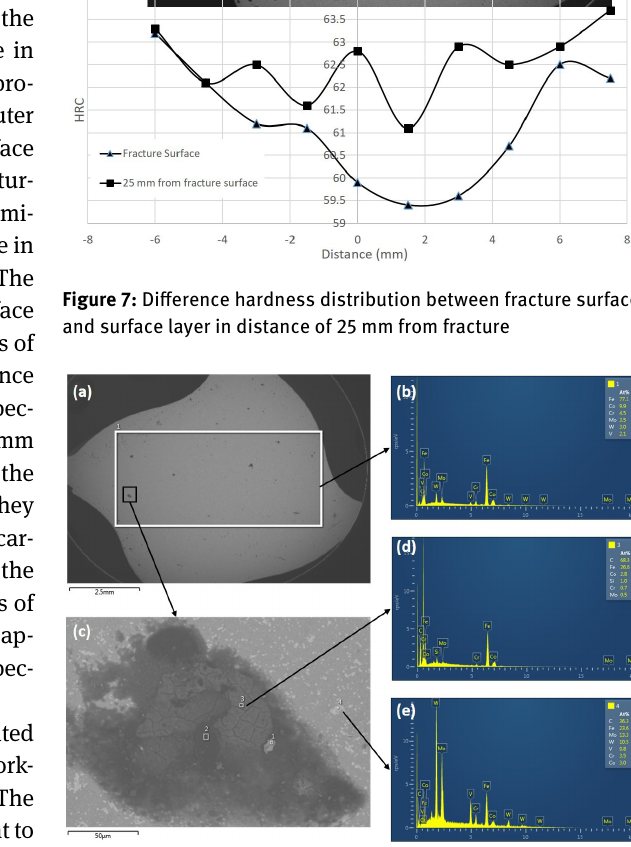
Figure 8: The surface structure at 25 mm from fracture (a)